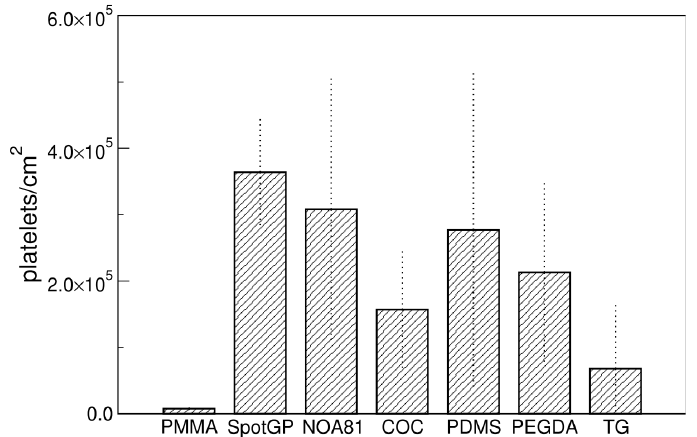
Figure 4. Platelets density measured by confocal microscopy. Data are means of at least three images and standard deviations are shown.